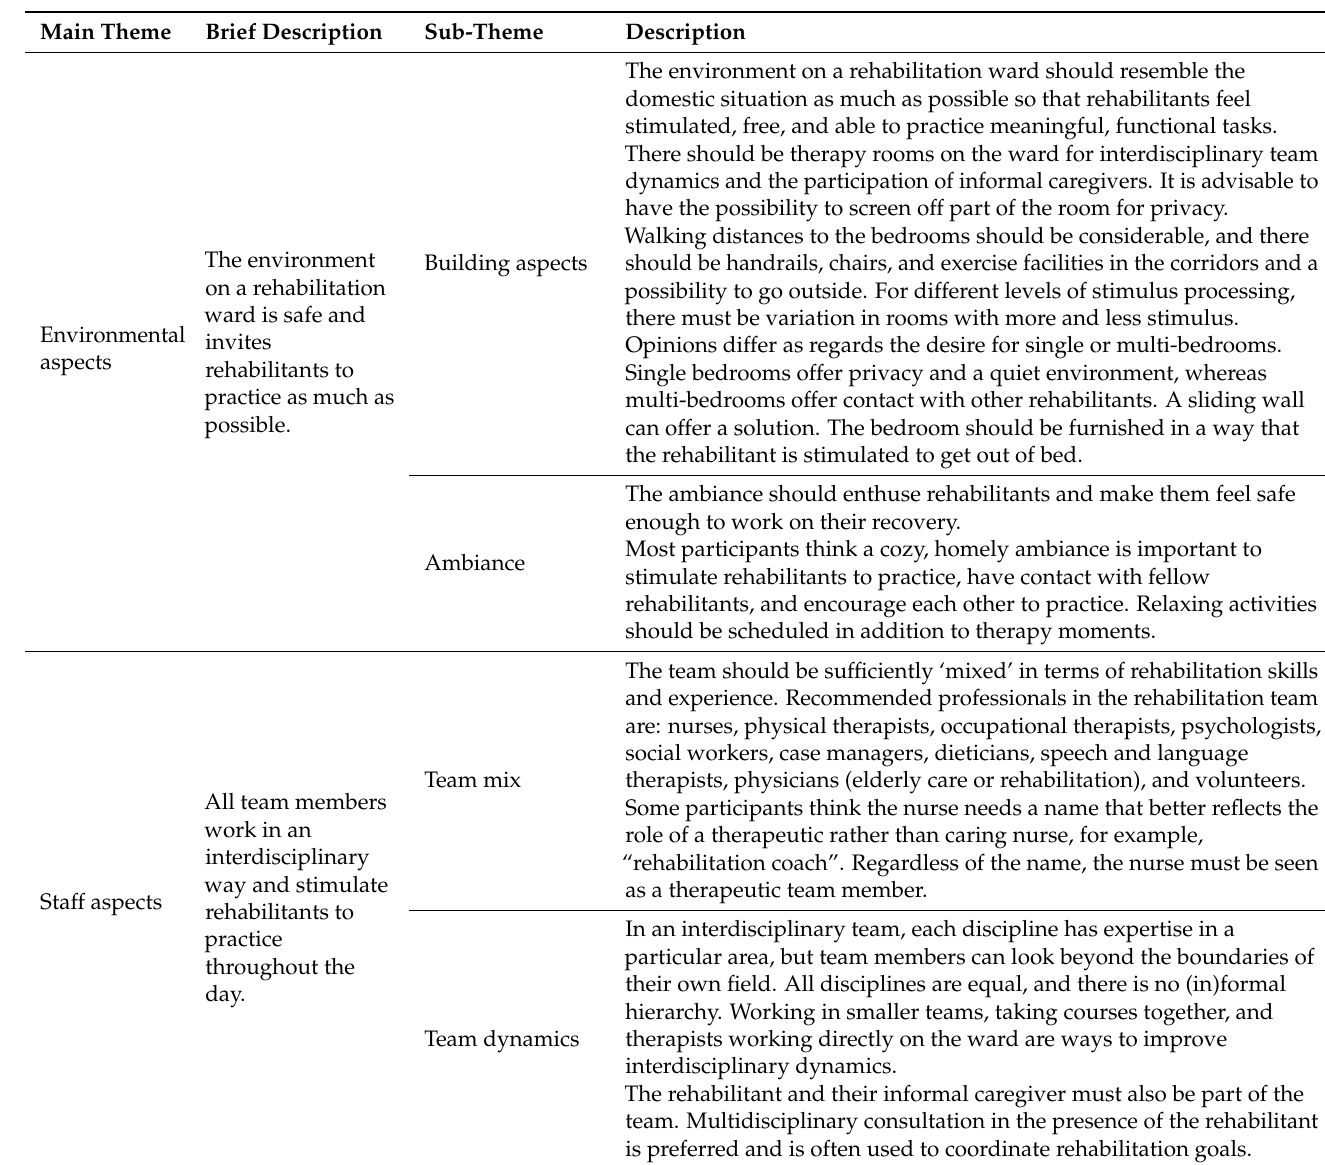
Table 3. Themes involving organizational